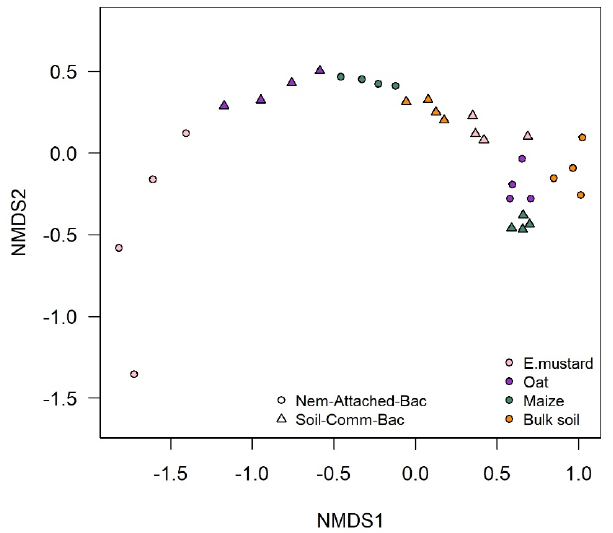
Figure 4. Effect of plant species on soil and P. penetrans attached bacterial communities. Non-metric multidimensional scaling (NMDS) plots are presented based on Pearson correlations of background-subtracted densitometric curves from denaturing gradient gelelectrophoresis. Stress value is 0.037, n = 4.